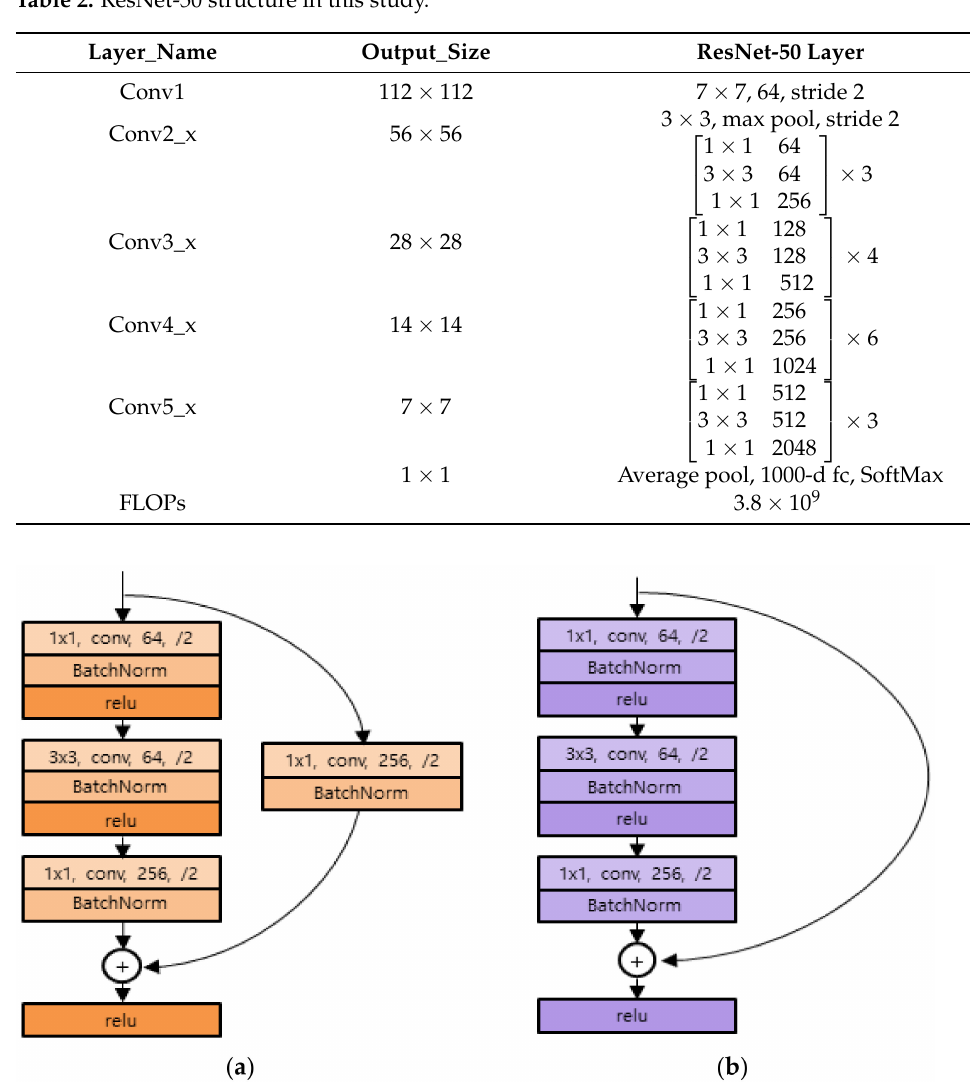
Figure 5. ResNet-50 structure and the residual block. ( a ) Convolution_block. ( b ) Identity_block. In the existing Faster R-CNN, the feature map extracted through the feature extractor is subjected to classification and box regression using the RPN. However, in the 3DFPE-DL, location regression is performed instead of the box regression of the RPN; as illustrated in Figure